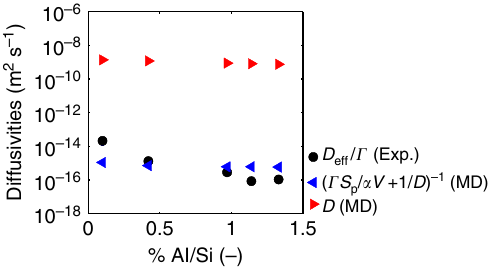
Figure 4 | Experimental diffusion coefficient. Effective diffusion coefficient ( D eff ) of water in silicalite-1 specimens with different volume/accessible surface ratio ( V / S p ). Experimental results (symbols) are fitted by the diffusion resistance model (black line) in equation (4) ( a ¼ 5.0 (cid:3) 10 (cid:2) 9 ms (cid:2) 1 ; coefficient of determination R 2 ¼ 0.94). Error bars are given by uncertainties in the determination of V / S p by imaging and D eff by water uptake experiments (s.d., 98% confidence interval). It is noteworthy that D D 0.6 D B ¼ 1.37 (cid:3) 10 (cid:2) 9 m 2 s (cid:2) 1 (from MD simulations of water within silicalite-1 in the adsorption regime, with D B ¼ 2.30 (cid:3) 10 (cid:2) 9 m 2 s (cid:2) 1 experimentally measured for water at 300K (ref. 69)) and G ¼ 1.11 (from experimental adsorption isotherms of water in silicalite-1 (ref. 27)) were considered for the model fitting. In the inset, the significant effect of surface barriers at low V / S p is highlighted. Red symbols represent experimental water diffusion in silicalite-1 samples reported in the literature (triangle 42 ) or provided by Michael Tsapatsis, University of Minnesota (square).